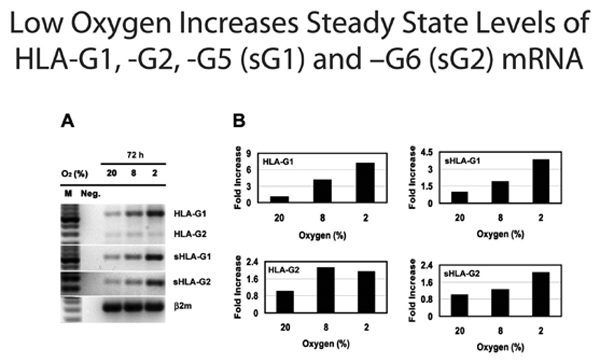
Exposure of term cytotrophoblast cells to low oxygen increases steady state levels of HLA-G mRNAs. Cytotrophoblast cells harvested from a term placenta using gradient centrifugation and purified by magnetic bead technology were >98% cytokeratin-7 positive. The cells were cultured for 72 hr under ambient (20% O2) and two hypoxic (8%, 2%) conditions. RT-PCR experiments were conducted using mRNA-specific primers. The results were analyzed using scanning densitometer against a stable message (β2m). Note that the abundance of transcripts encoding HLA-G1, -G2, -G5 (sHLA-G1), and -G6 (sHLA-G2) were inversely related to levels of O2. Under 2% O2, mRNAs encoding HLA-G1 and -G5 were more profoundly enhanced (×7, ×4, respectively) than those encoding HLA-G2 and -G6 (×2, ×2, respectively).